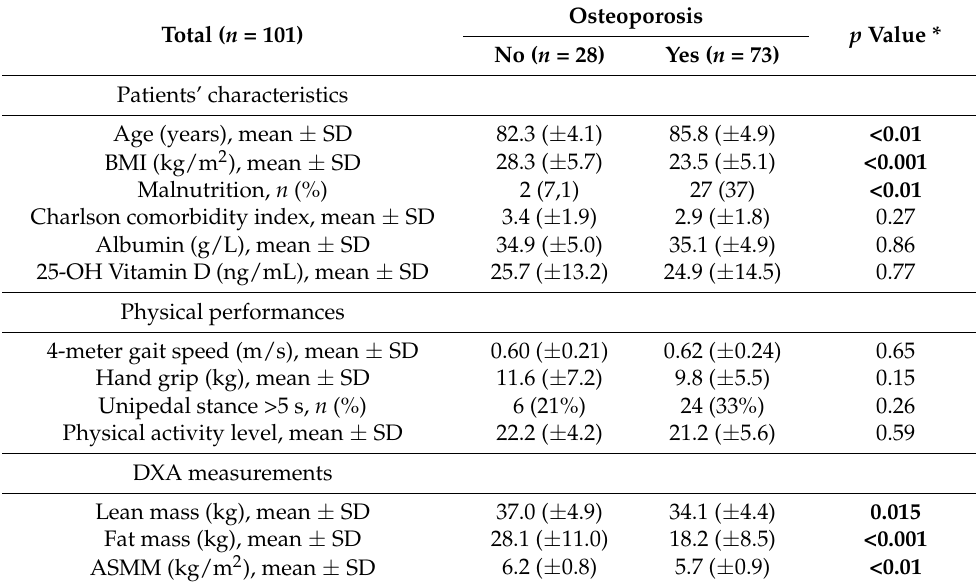
Table 4. Patients’ characteristics according to osteoporosis diagnosis ( n = 101). Total ( n = 101)